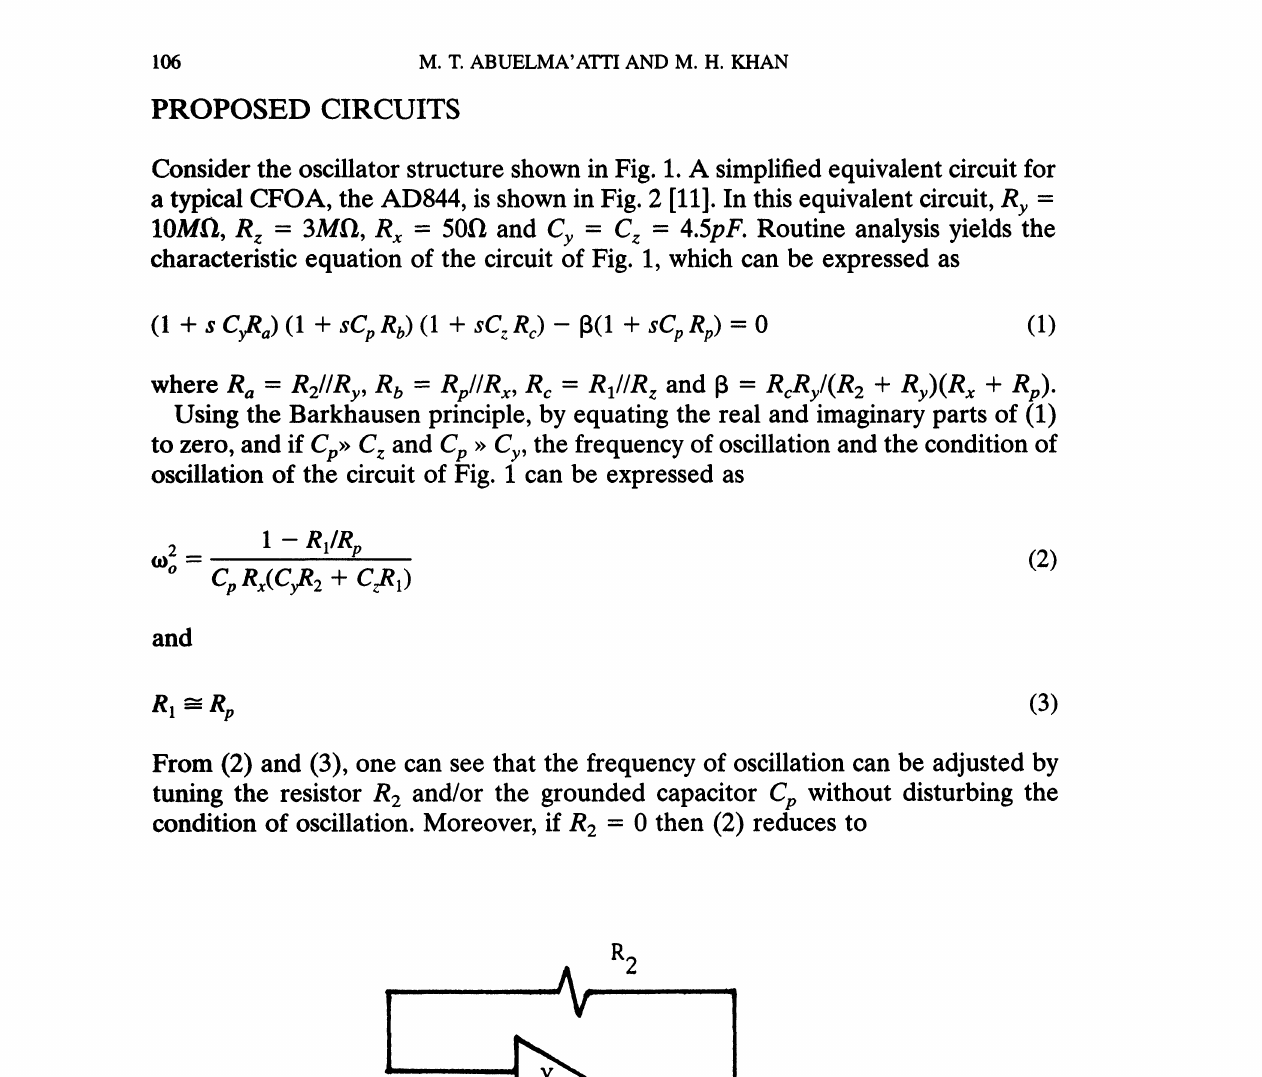
FIGURE Partially active-R Oscillater